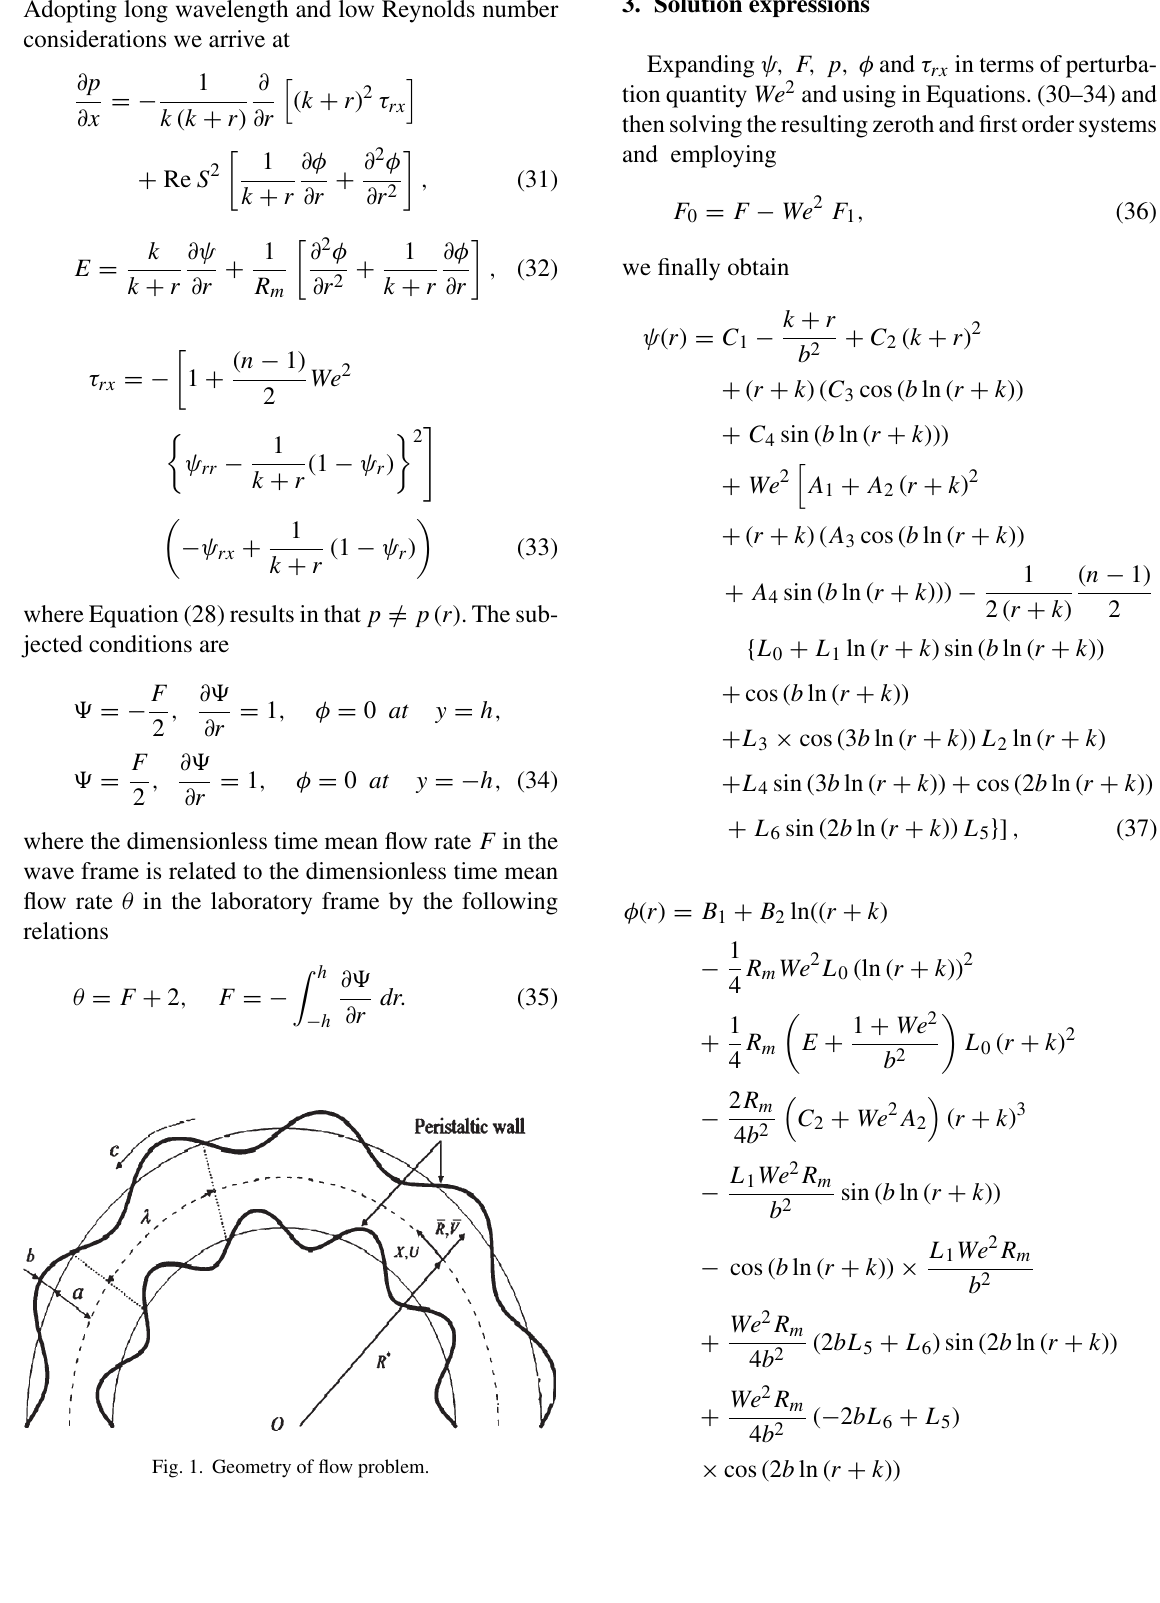
Fig. 1. Geometry of flow